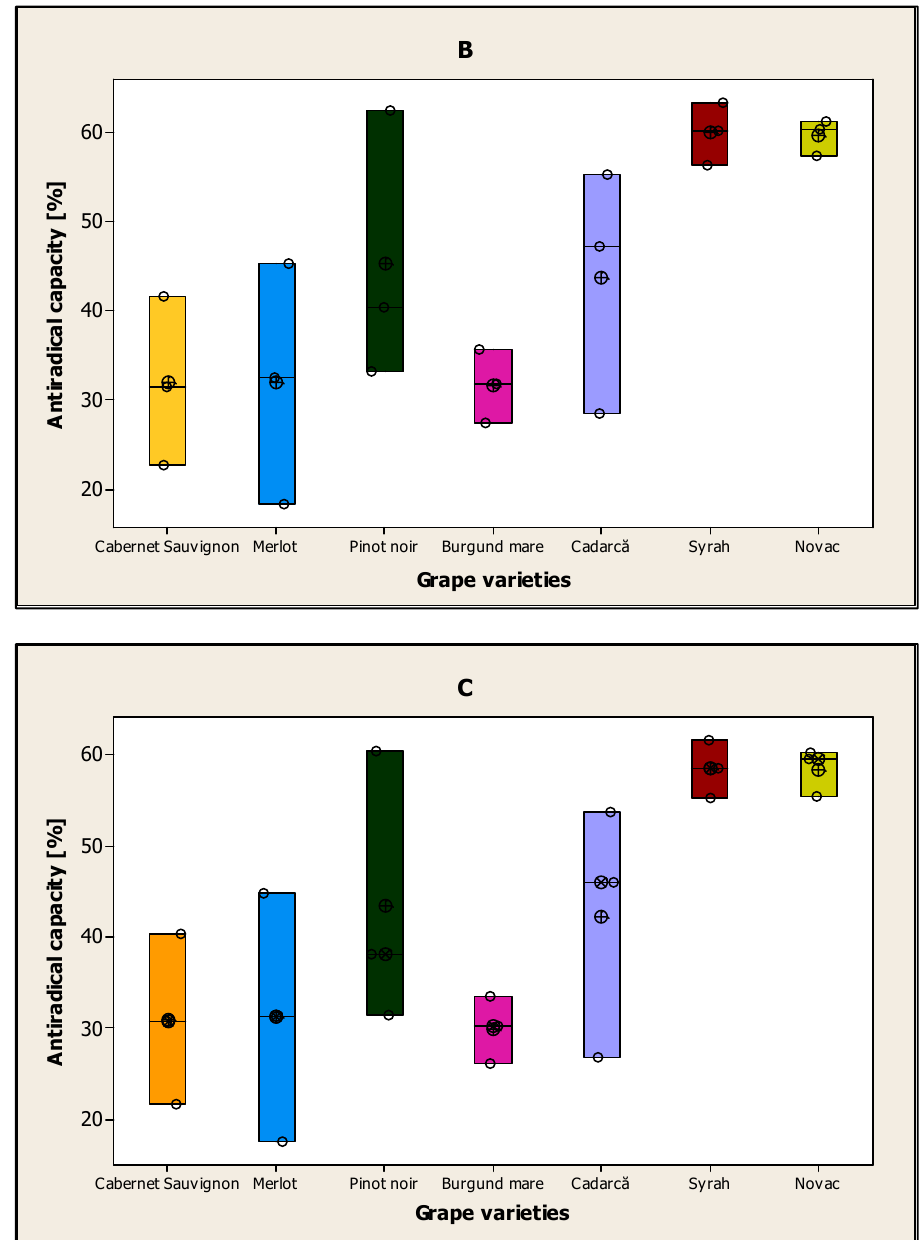
Figure 3. ( A ) Antiradical capacity determined from the seeds of the seven grape varieties on the first day; ( B ) antiradical capacity determined from the seeds of the seven grape varieties on the 14th day; ( C ) antiradical capacity determined from the seeds of the seven grape varieties on the 30th day .